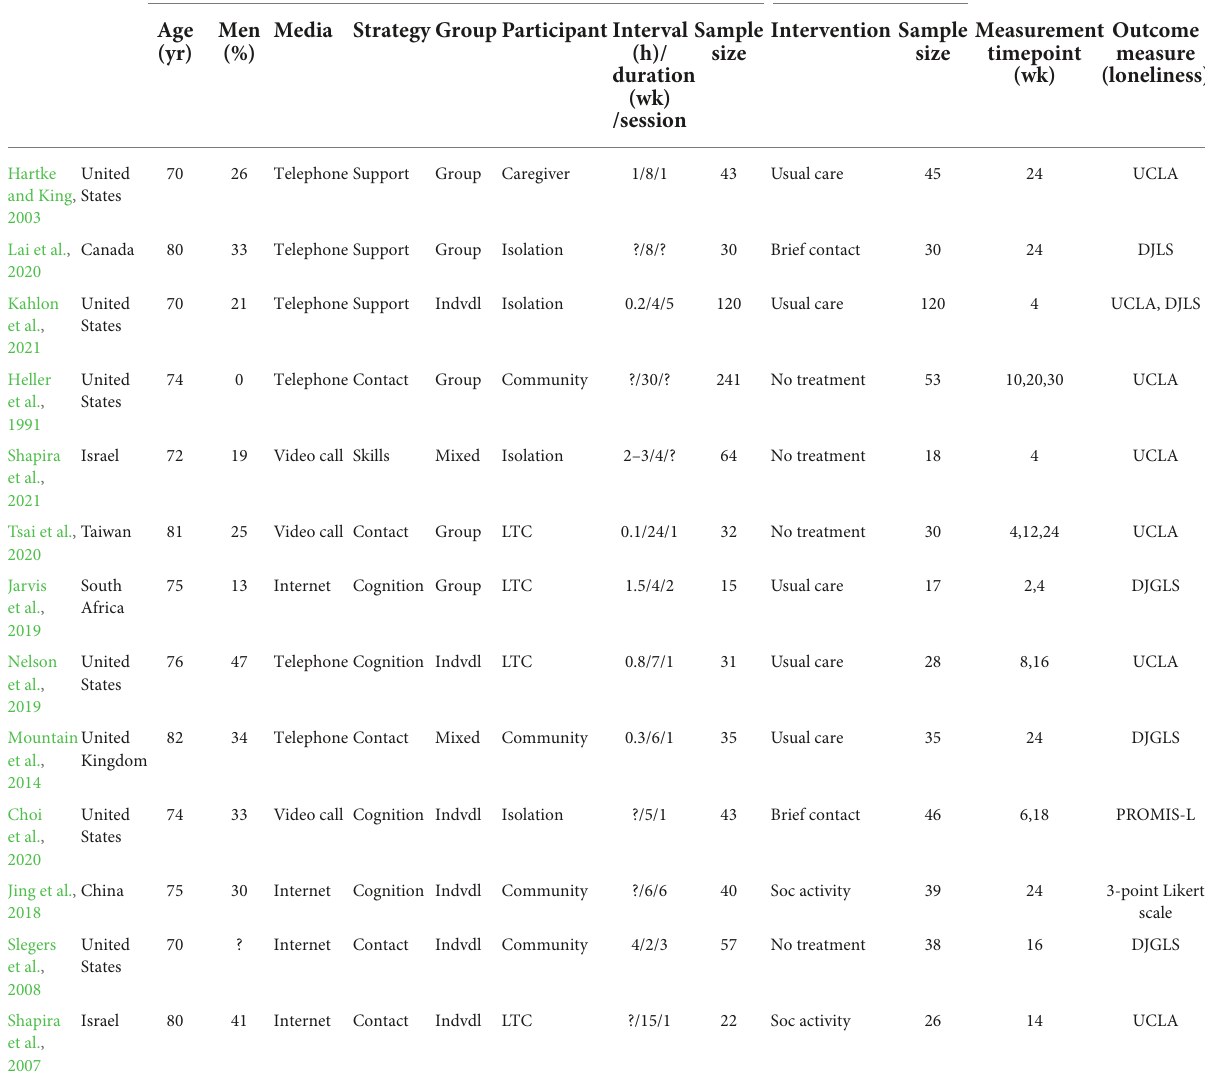
TABLE 1 Characteristics of the Included